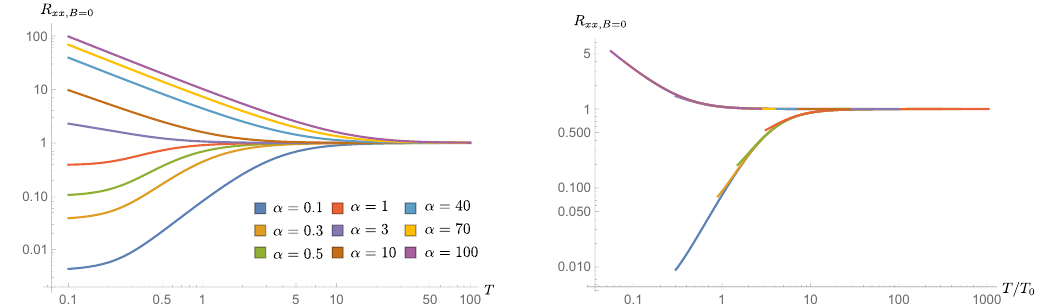
Figure 9 . Temperature dependence of the resistivity versus disorder strength at zero magnetic (cid:12)eld. Left: the metal-insulator transition driven by the disorder strength (cid:11) , which corresponds to the right plot of (cid:12)gure 6 with R xx ( B = 0) = 1 =(cid:27) DC . Right: scaling of resistivity with scaled temperature T=T 0 . The collapse of data into two separated curves both in the metallic and insulating sides is manifest. We have (cid:12)xed K = (cid:0) 1 = 6 and (cid:26) = 1.